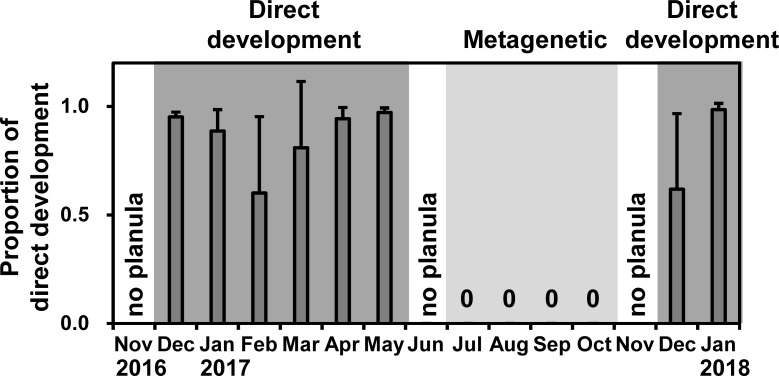
Temporal variations in proportion of direct development from planulae.Bars and error bars in the top figure are mean values and SD. No planula indicates that no female bore planulae. Dark and light shades indicate the direct-development and metagenetic periods, respectively.